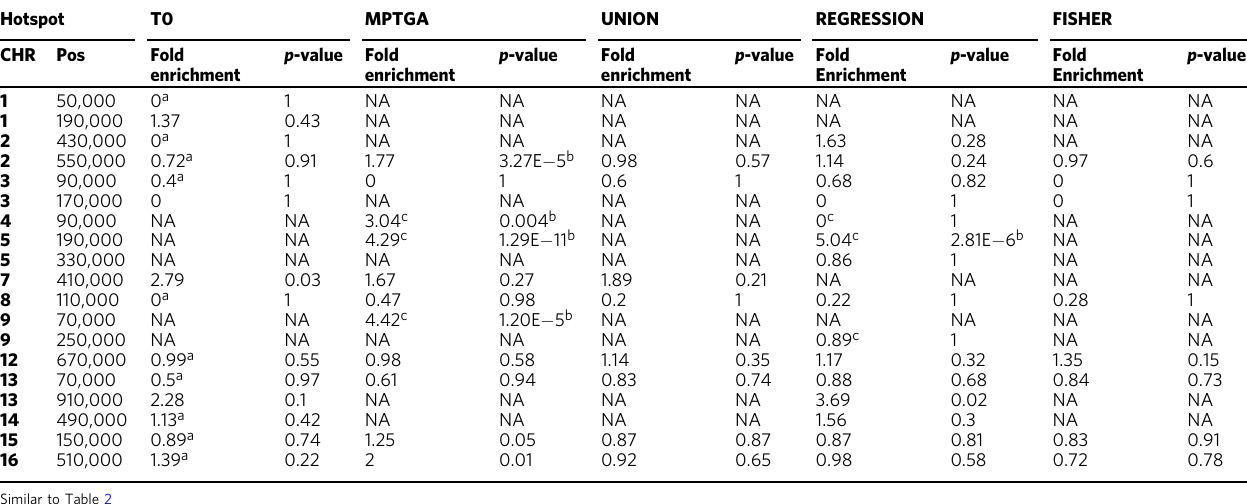
Table 5 Enrichment analysis of genes that can extend yeast replicative lifespan in hotspots